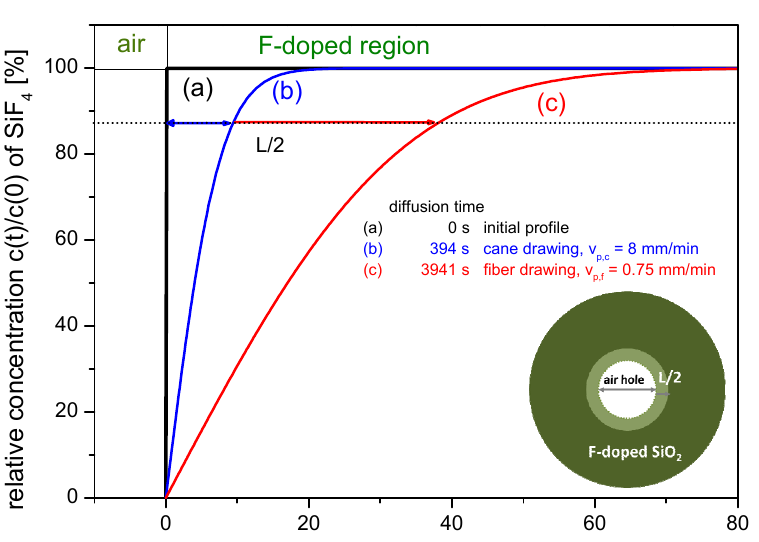
Figure 4. Simulated profiles of fluorine diffusion as a function of time starting with a step index profile (simulated for preform geometry conditions): ( a ) assumed initial profile; ( b ) simulated profile after 394 s; and ( c ) simulated profile after 3941 s. The inset figure shows a sketch of an F-doped tube, the dark green region represents the original F-concentration, the light green represents the region with lower